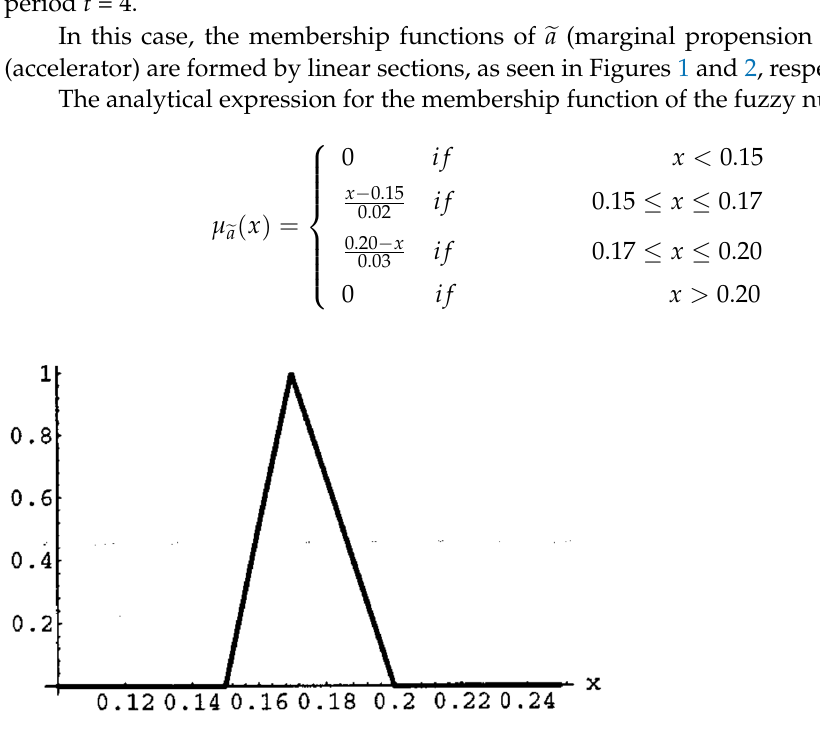
Figure 1. Membership function of marginal propension to save (mps).